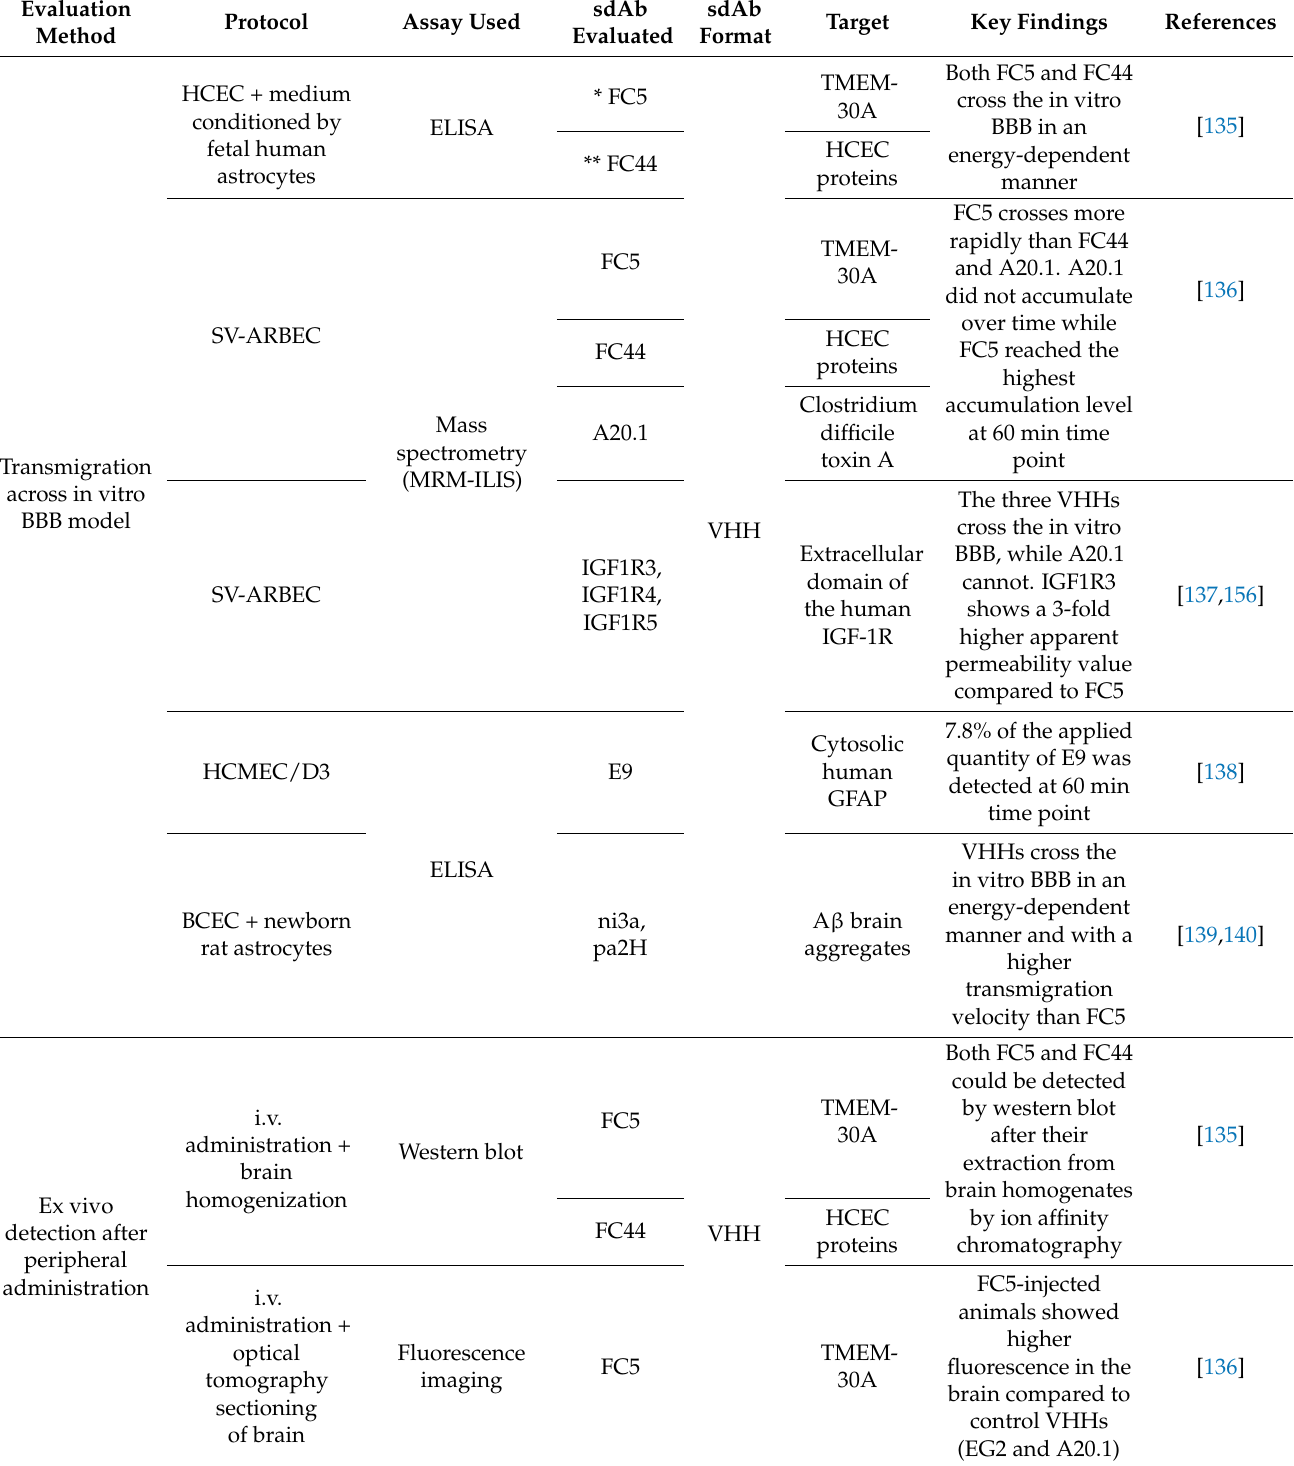
Table 7. Nonexhaustive list of techniques used to assess brain penetration of